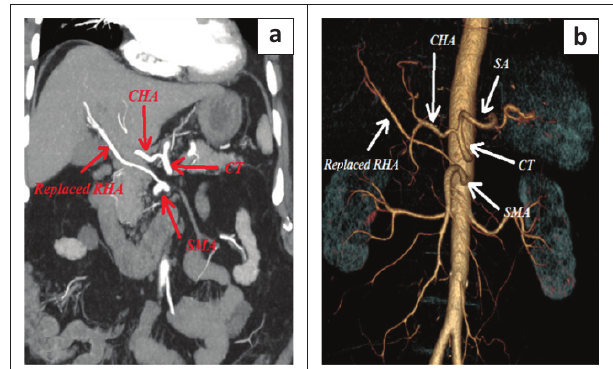
FIGURE 1: Schematic representation of the different types of coeliac trunk variants according to Ulflacker’s classification: (a) type I; (b) type II; (c) type II; (d) type III; (e) type V; (f) type V; (g) type VI; (h) type VIII.